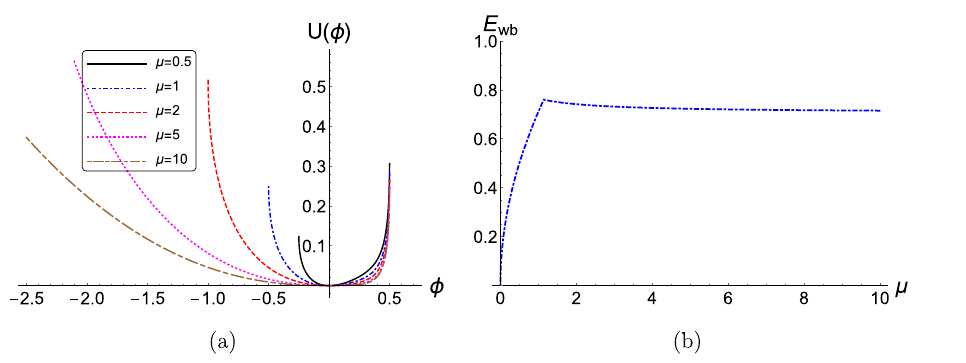
Figure 3. (Color online) ( a ) The effect of the variation of the ion mass ratio µ = m 2 / m 1 on ( a ) The pseudopotential U (φ) is depicted, versus the electrostatic potential φ . ( d ) The variation of the minimum normalized wave-breaking electric field amplitude E wb versus the ion mass ratio µ . The parameter values are: δ = 0.5 , κ = 2.5 , Q = 1 and M = 1 . The numerical values adopted here, as imposed by the maximum allowed value(s) of U (φ) , i.e. U max = I , are presented in Table III (see Online Appendix